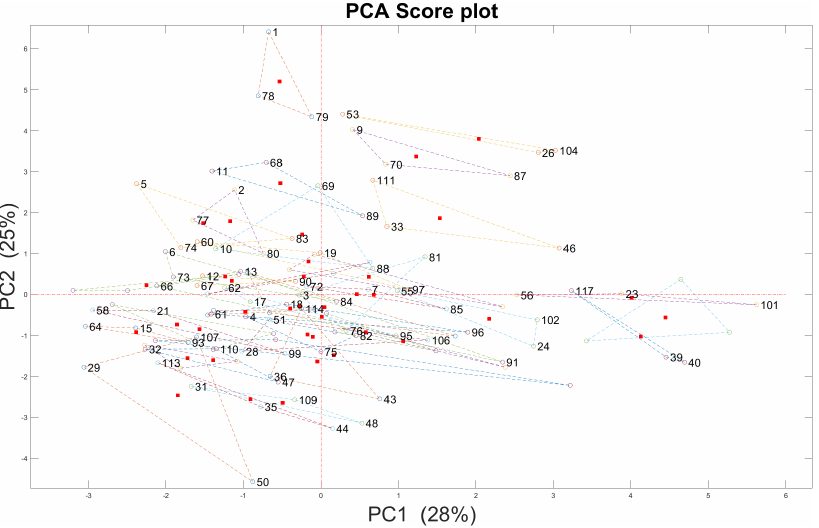
Figure 8. 117 bottles New Zealand Pinot noir wines’ chemical parameters are characterized by PCA score plots.